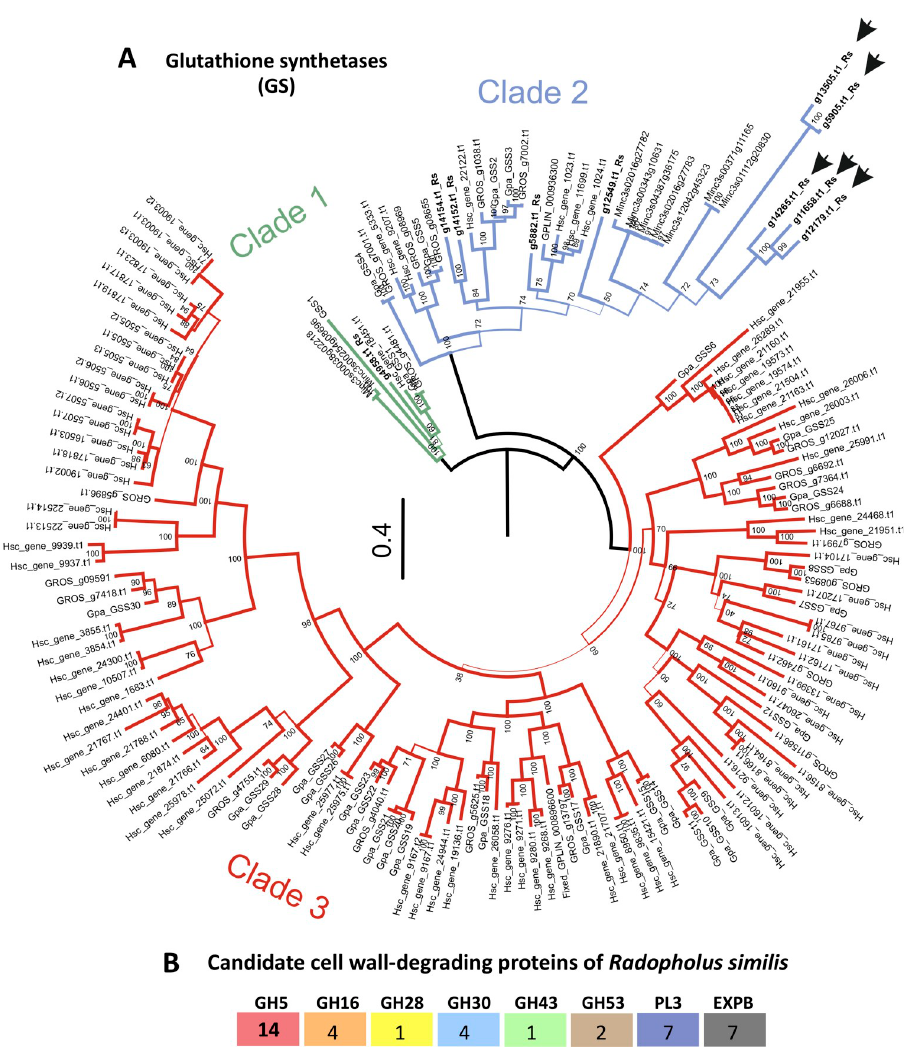
Fig 1. Identification of selected candidate effector gene families of Radopholus similis . (A) Maximum-likelihood phylogenetic tree of glutathione synthetase (GS) proteins of R . similis with GS sequences of other plant-parasitic nematodes (adapted from [41]). Clade 1 (green) contains the “progenitor” GS sequence of each nematode species included in the tree. Clade 2 (blue) represents the first expansion of GS genes in plant-parasitic nematodes and contains 9 GS coding genes from R . similis . Arrows indicate putative secreted GS-like effectors of R . similis . Clade 3 (red) represents the second GS genes expansion, and contains all known GS-like effectors of cyst and reniform nematodes. (B) Number of genes encoding putative cell wall-degrading proteins in R . similis . GH: glycosyl hydrolyse; PL: pectate lyase; EXPB: expansin-like.